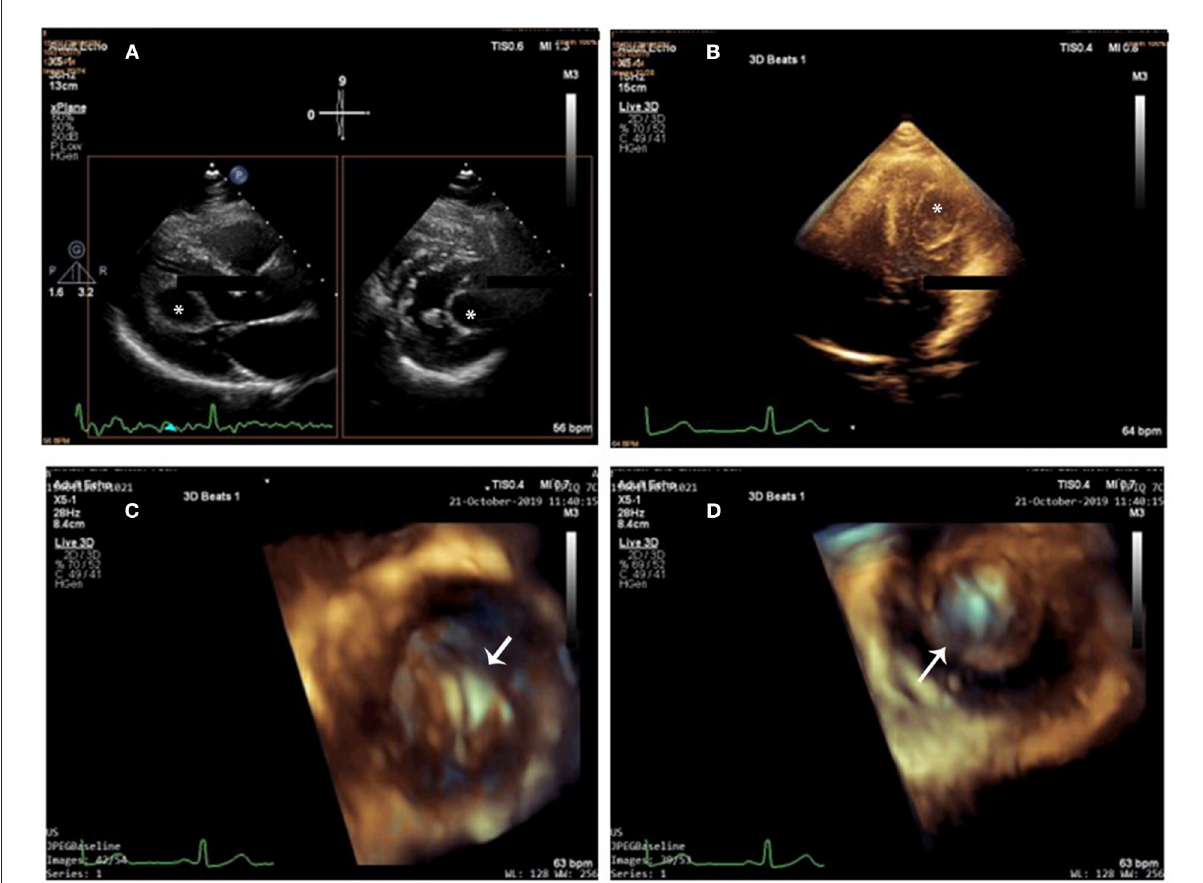
FIGURE1 Cardiac cyst on 2D-TTE and 3D-TTE. (A) 2D X-plane imaging showed a drop-like and echo-lucent intramural structure (star) bulging into the left ventricle from the myocardium of the left ventricular lateral wall. (B) 3D full-volume imaging: The cyst was round and unilocular, with liquid content and well-defined edges (star). (C,D) 3D zoom imaging (en-face view) from outside (C) and from inside (D) perspectives (arrow), the cyst wall looked homogeneously smooth and hyper-echogenic. Cystic sludge was